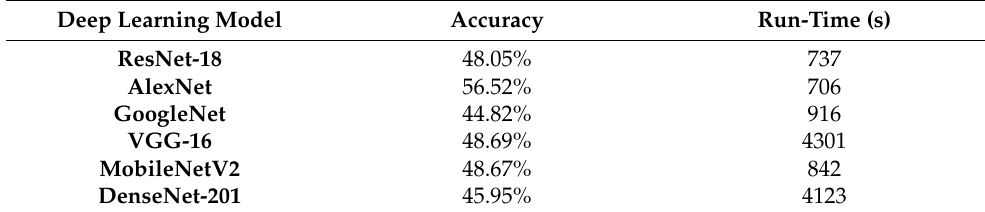
Table 4. Comparison between the six DL models on Dataset 1 before pre-processing.